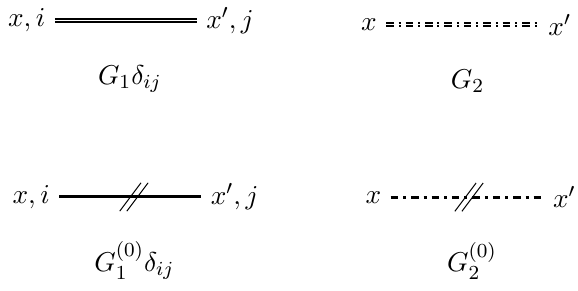
Figure 10 . Top: diagrammatic representation of the standard massive propagators: G ~φ 2 u , and G 2 with m 2 m 2 = λ 0 | 1 2 N | ≡ euclidean zero-mode part of the massive propagators: G (0) a = ( V d m 2